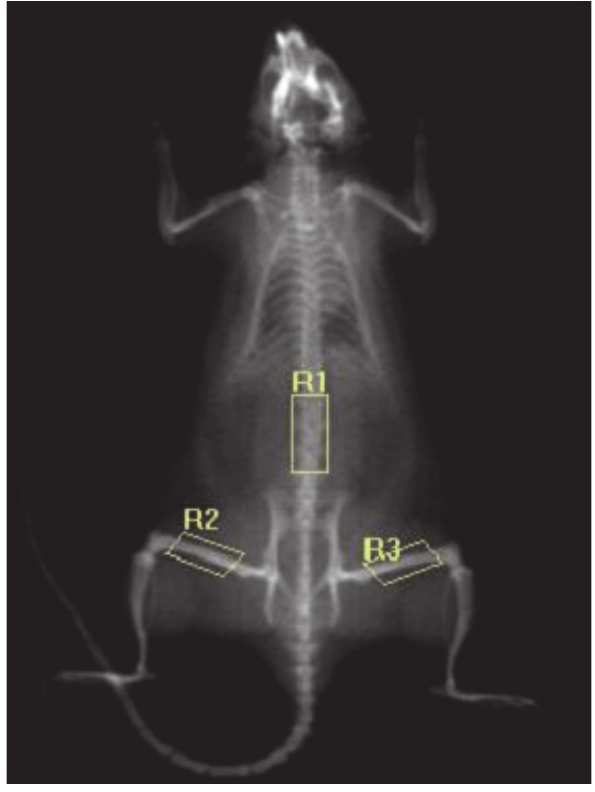
Fig. 1. Evaluation of BMD in three areas of the rat skeleton.